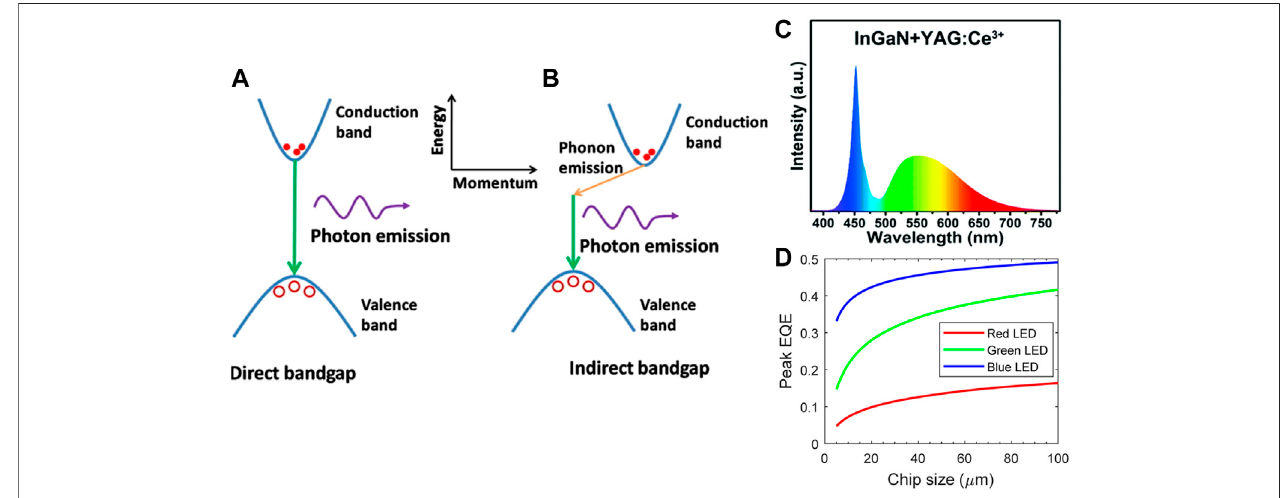
FIGURE 5 | Comparison of direct (A) and indirect (B) bandgap behaviors when there is exciton recombination (Kasap and Sinha, 2013). (C) Structure of high ef fi cient double-heterostructure blue LED fabricated and published in 1994 (Nakamura et al., 1994). (D) Emission spectrum of a white LED is fabricated by a blue LED chip with YAG: Ce phosphor (Schubert,